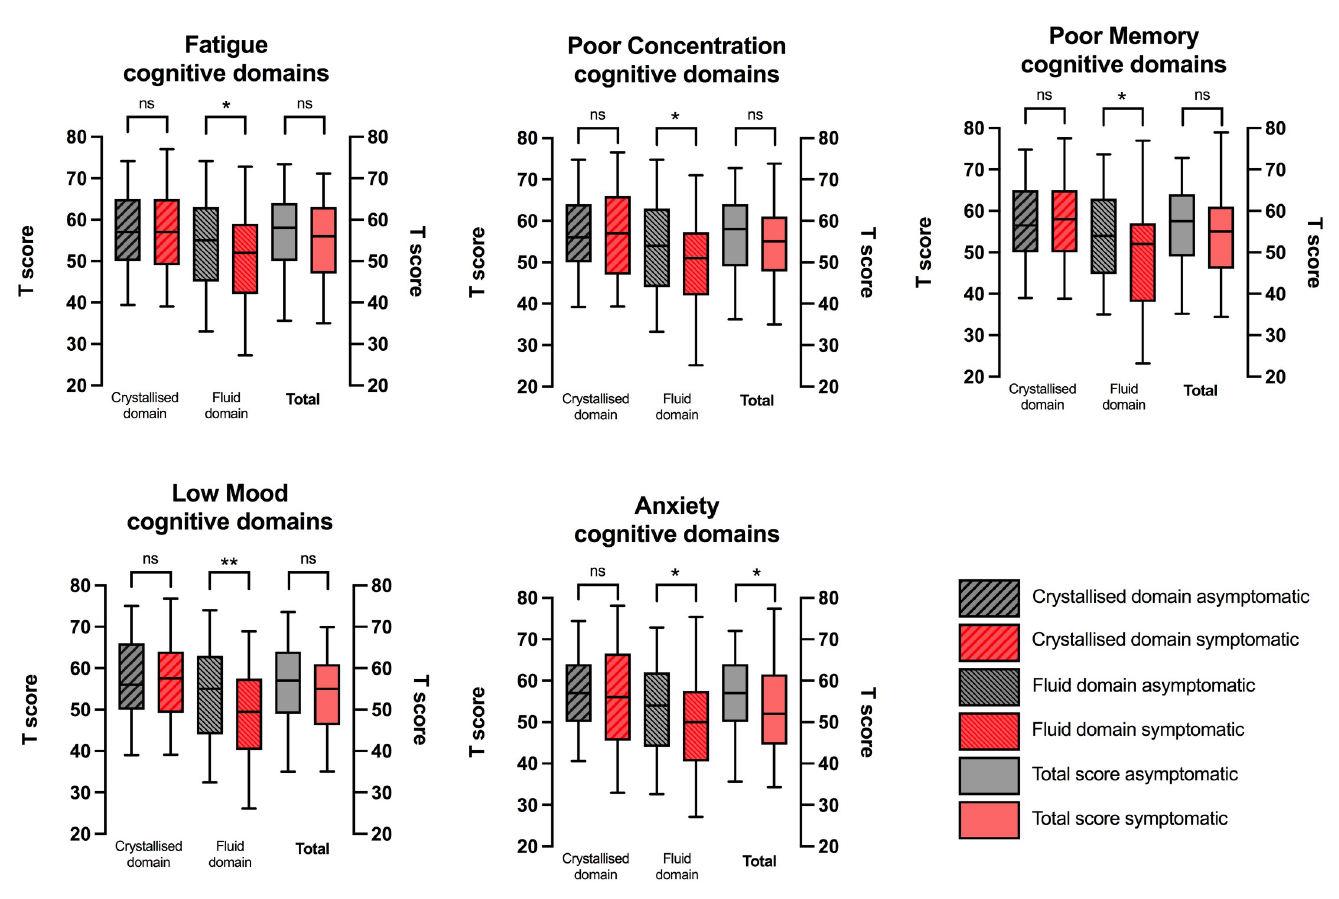
Fig 3. Comparison of fluid and crystallised cognitive domain scores between those with vs. without symptoms of cognitive dysfunction and mood disorder. Cognitive scores were all obtained using the standardised NIH-TB cognitive battery. The differences indicated refer to a statistically significant numerical difference between the group scores for patients with an ongoing symptom vs. those without � p < 0.05; �� p < 0.01.